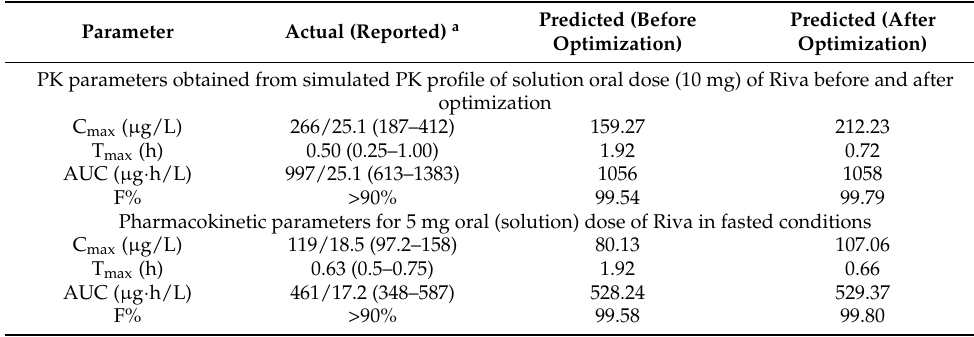
Predicted (Before Predicted (After Optimization) Optimization)